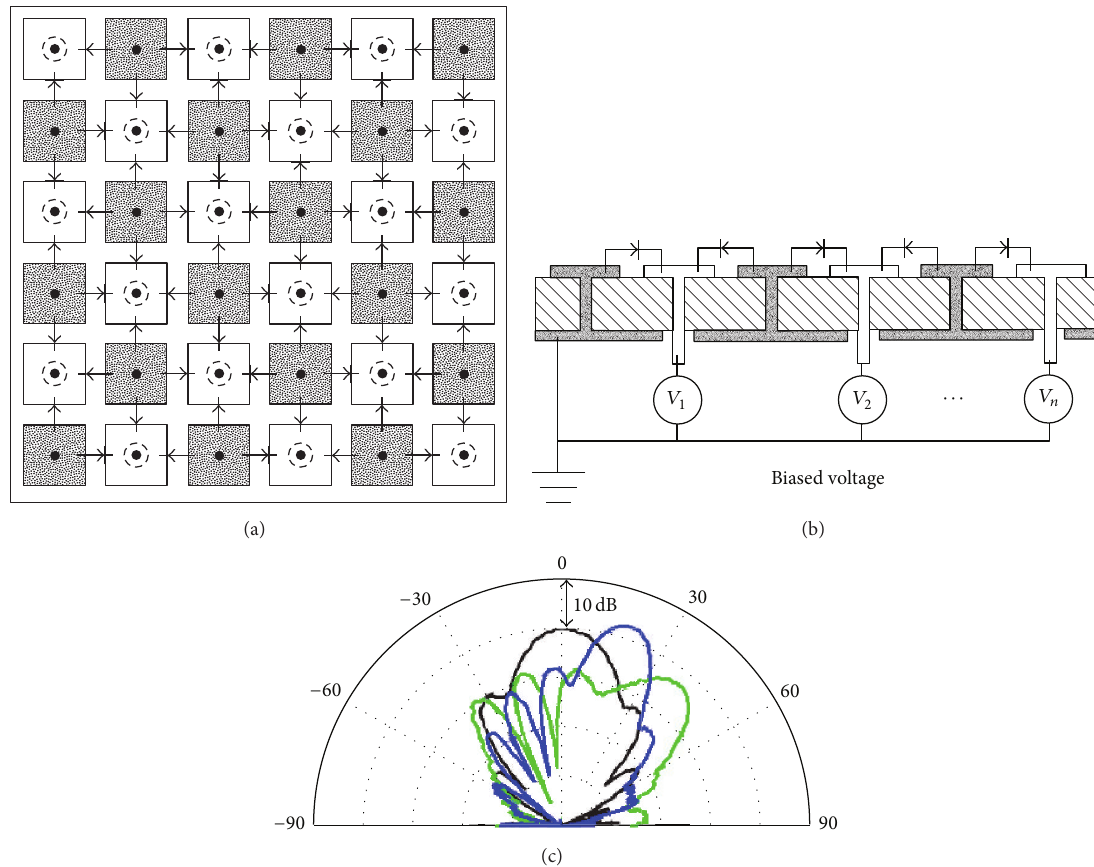
Figure 6: (a) The top view and (b) side view of an electrically tunable impedance surface with special arrangement of varactors and (c) the radiation patterns for three different phase gradients [63, 64] (reproduced by permission of the Institution of Engineering & Technology).